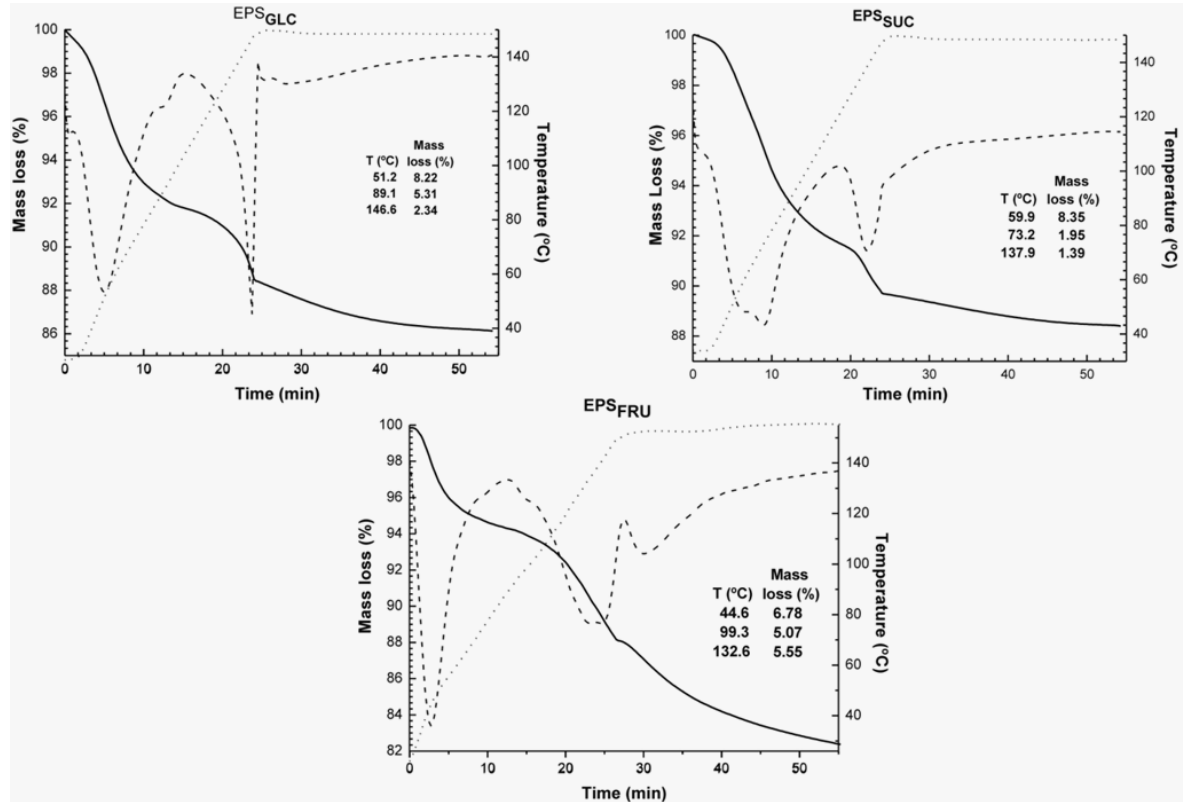
Figure 2. TG (—) and DTG (---) curves for botryosphaerans EPS within the 30–150 °C temperature range. The heating rate was 5 °C/min, with an isothermal hold at 150 °C for 30